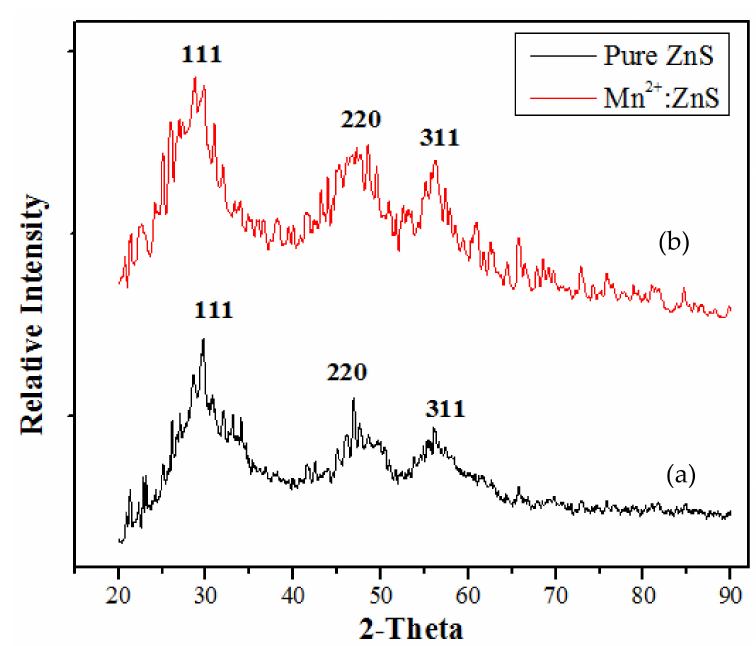
Figure 4. XRD patterns of ( a ) pure ZnS Qds and ( b ) Mn 2+ :ZnS Qds. Figure 5 shows the FTIR scan of Mn 2+ :ZnS Qds. Several features can be found in the